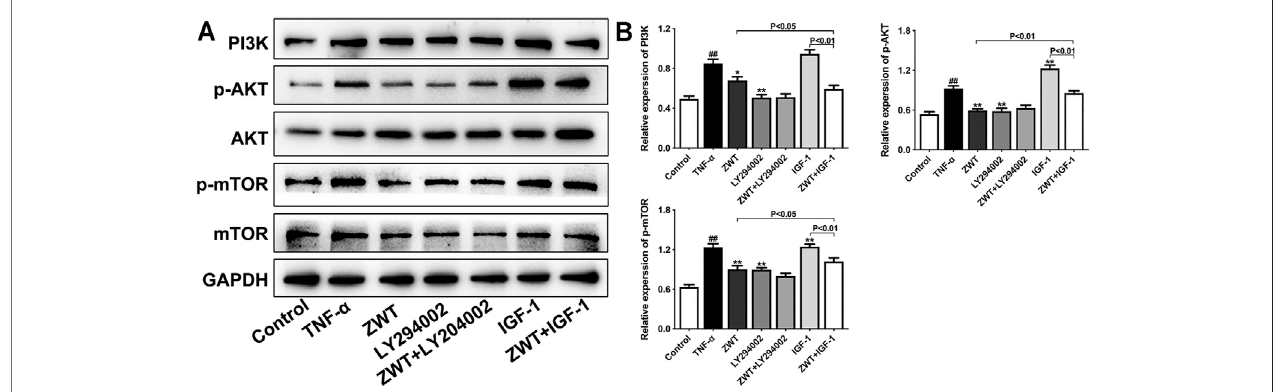
FIGURE 8 | The intervention of PI3K inhibitor and agonist against ZWT. (A,B) The protein blots and quantitative analysis of PI3K, p-AKT, and p-mTOR. The obtainedvaluesofPI3KwerenormalizedtoGAPDH;p-AKTvalueswerenormalizedtoAKT.p-mTORvalueswerenormalizedtomTOR.Dataarerepresentedasmean ± SD ( n (cid:2) 3). # p < 0.05, ## p < 0.01 versus control group, * p < 0.05 and ** p < 0.01 versus the TNF- α